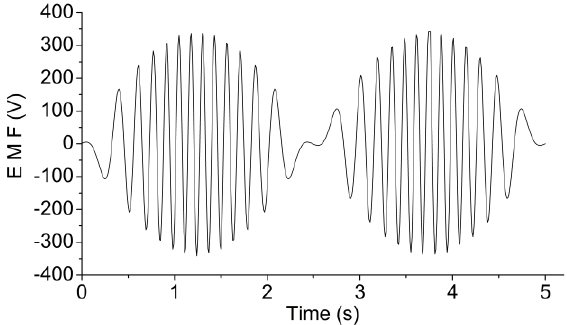
Figure 1. Electromotive force (EMF) waveform of a tubular linear wave energy converter (LWEC) (1 phase).